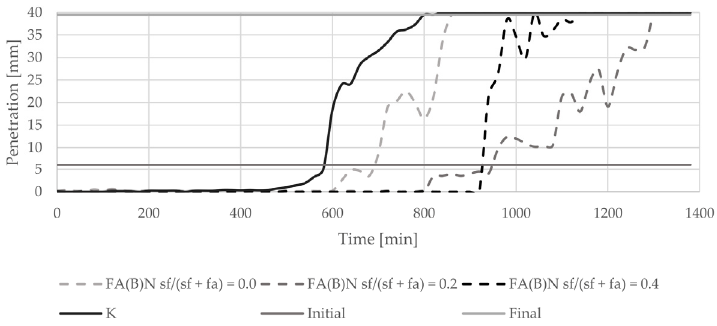
Figure 5. Setting time results of cement pastes with biomass fly ash activated by silica fume addition.